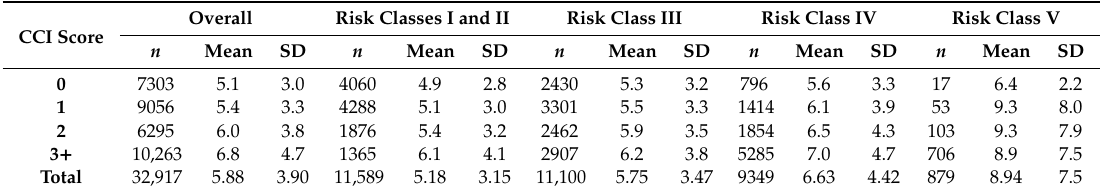
Table 2. Length of hospital stay in days by CCI category and PSI class among patients with CABP who received ceftriaxone and macrolide on day 1 or 2 of